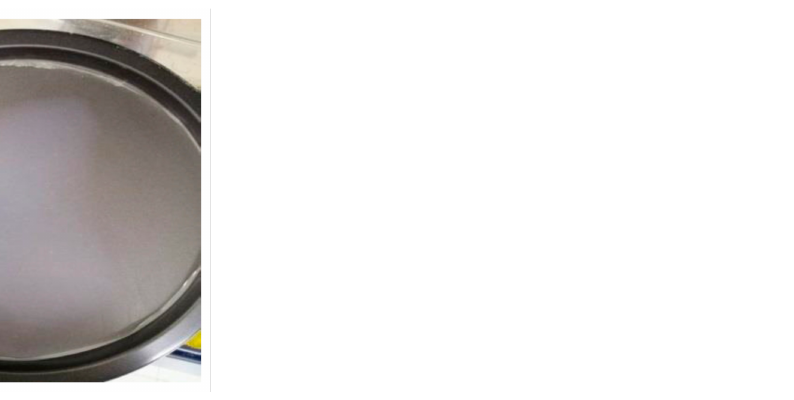
Figure 1. Dried film of the thermoplastic starch-dolomite (TPS-DOL) biocomposite in the Teflon- coated mould.